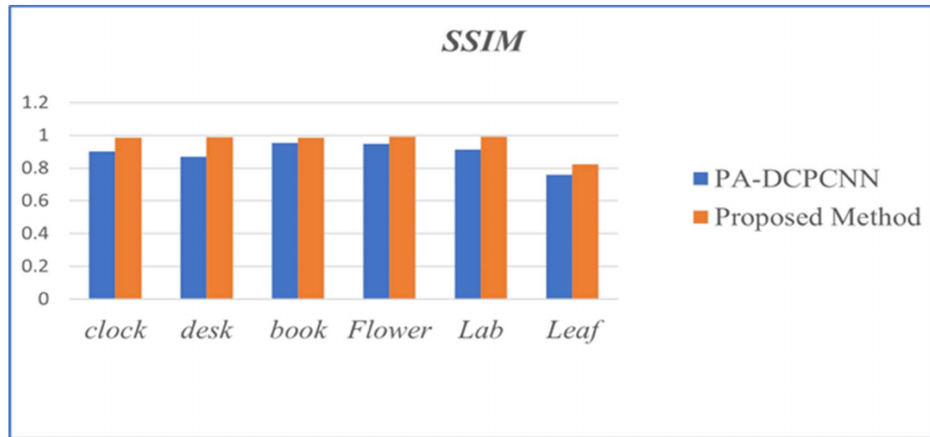
Figure 26. Performance evaluation of image-fusion techniques in reference to SSIM